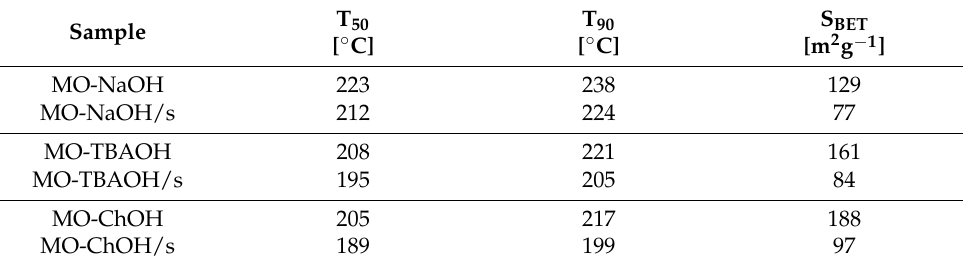
Table 2. Temperatures of 50% (T 50 ) and 90% (T 90 ) conversion of toluene in a reaction of total oxida- tion over mixed oxides obtained by the calcination of precursors at 450 °C, and the specific surface area of the catalysts (S BET ).